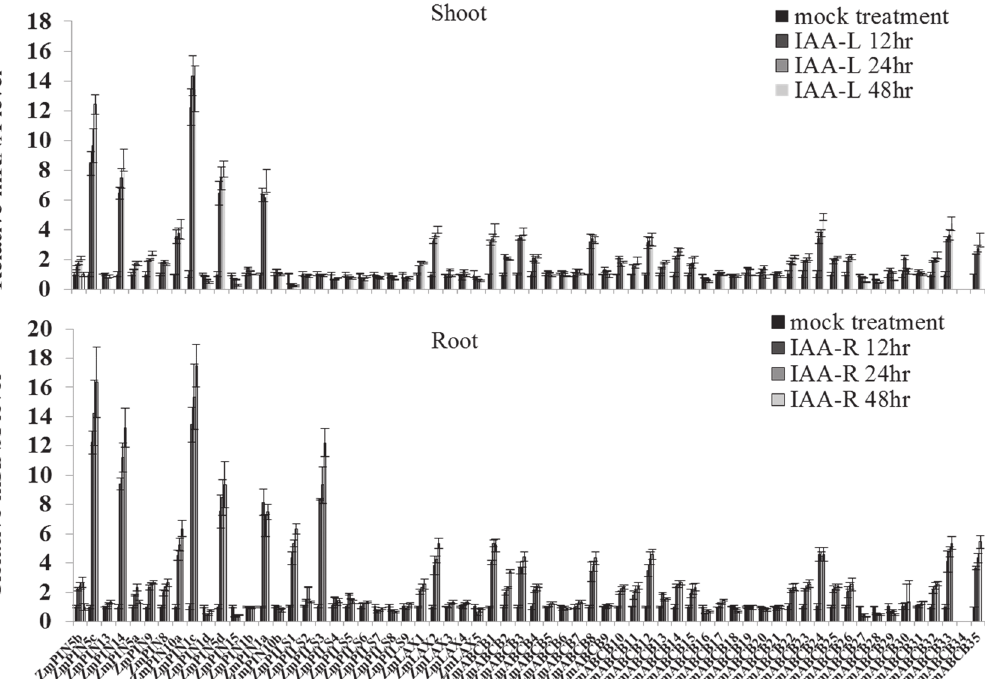
Fig 4. Real-time quantitative RT-PCR (qRT-PCR) analysis of ZmLAX , ZmPIN , ZmPILS and ZmABCB genes in plants under IAA treatment in both shoots (A) and roots (B). Total RNA was extracted from the seedlings shoots and roots of maize for expression analysis. The histogram shows the relative expression levels of ZmLAX , ZmPIN , ZmPILS and ZmABCB genes under IAA treatment (10 μ M, 48 hours) compared to the mock expression level. Untreated seedlings were used as mock seedlings. The relative mRNA level of individual genes was normalized with respect to the ZmACTIN gene (defines as 1). The data were analyzed by five independent repeats, and standard deviations were shown with error bars.